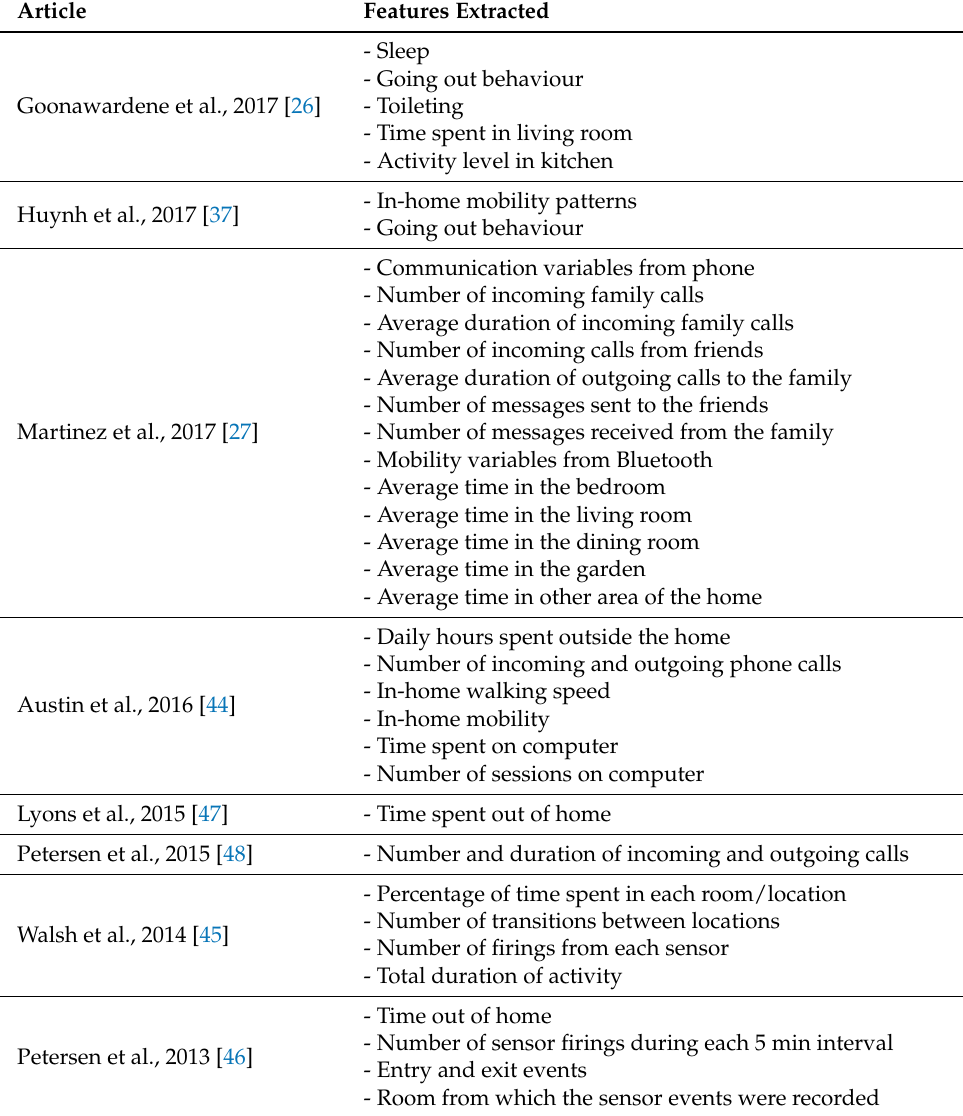
Table 5. Activity features extracted from sensor